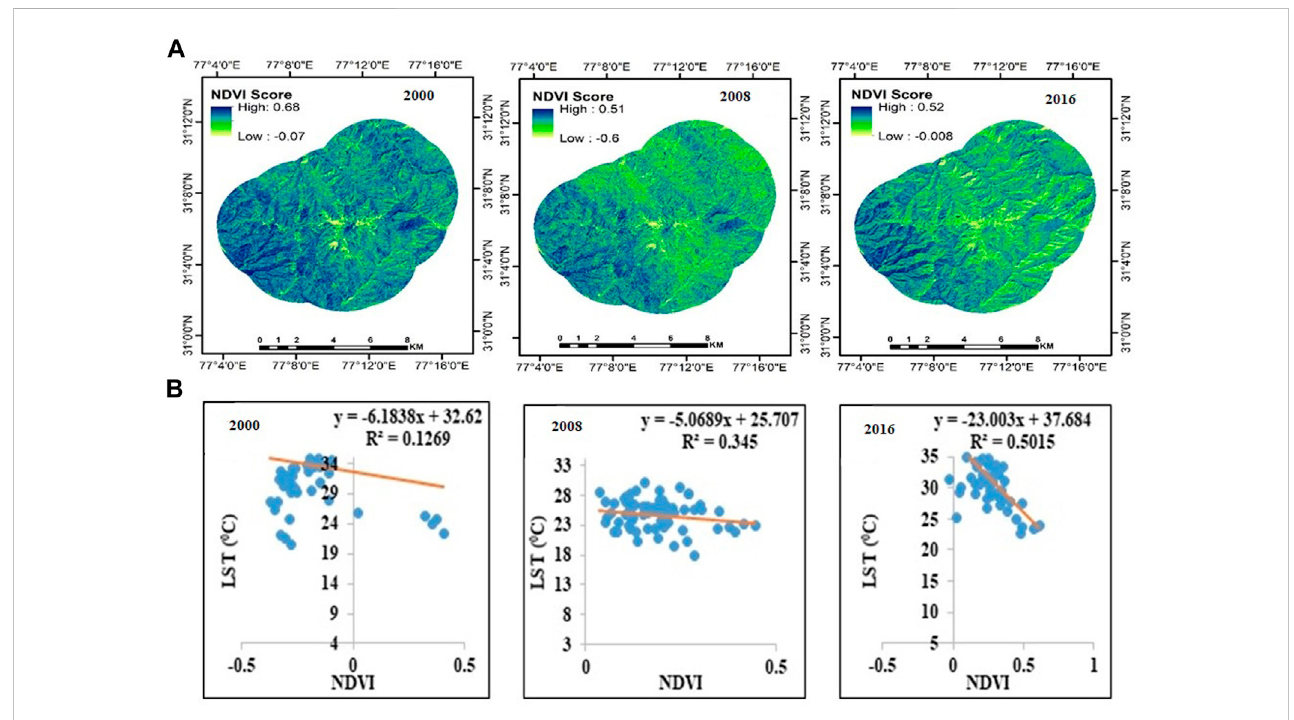
FIGURE 7 Change in NDVI (A) and degree of association of NDVI with LST (B) for